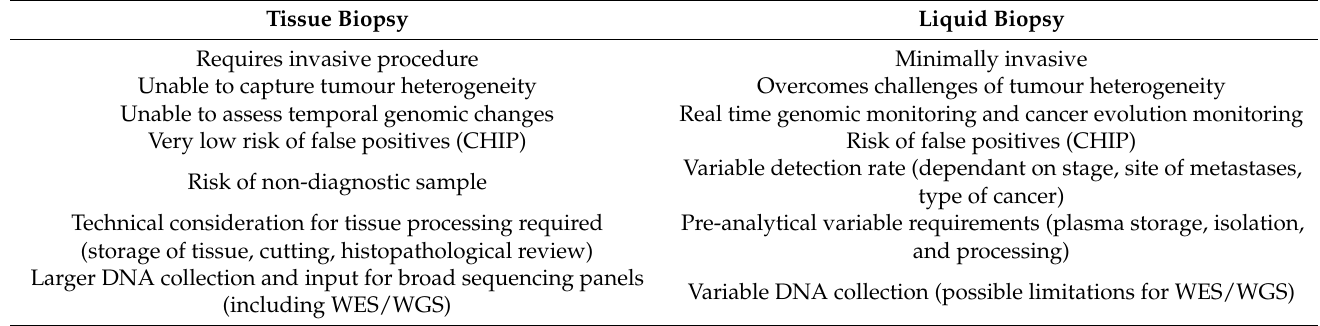
Table 1. Advantages and challenges of tissue and liquid